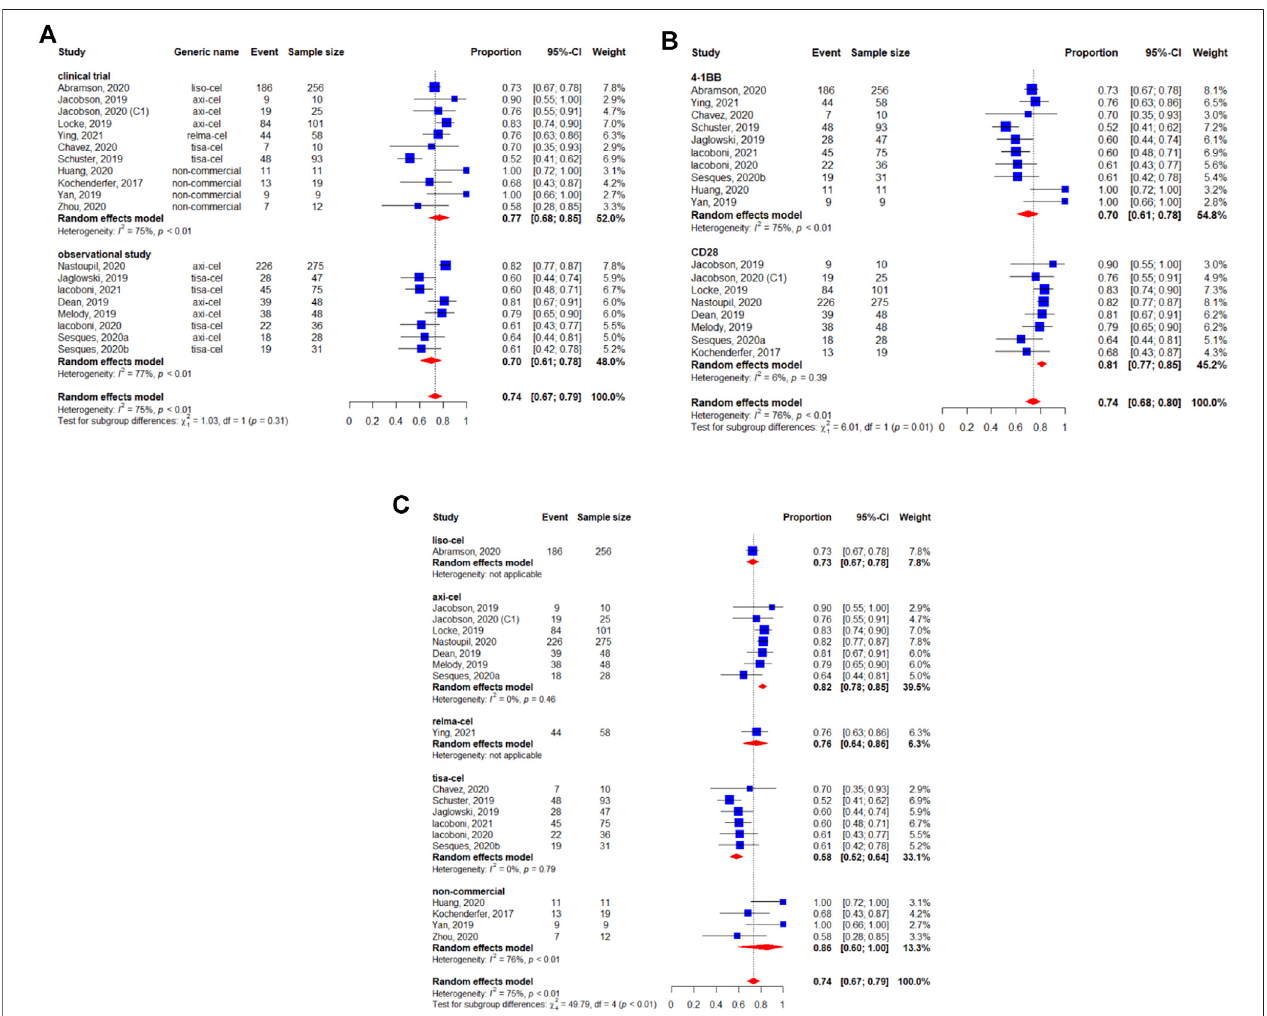
FIGURE2| Subgroupanalysesofbestobjectiveresponserate(BOR)ofpatientswithdiffuselargeB-celllymphoma(DLBCL)treatedwithchimericantigenreceptor T cells (CAR-Ts) according to (A) study design, (B) the costimulatory domain, and (C) type of chimeric antigen receptor T cells (CAR-T).